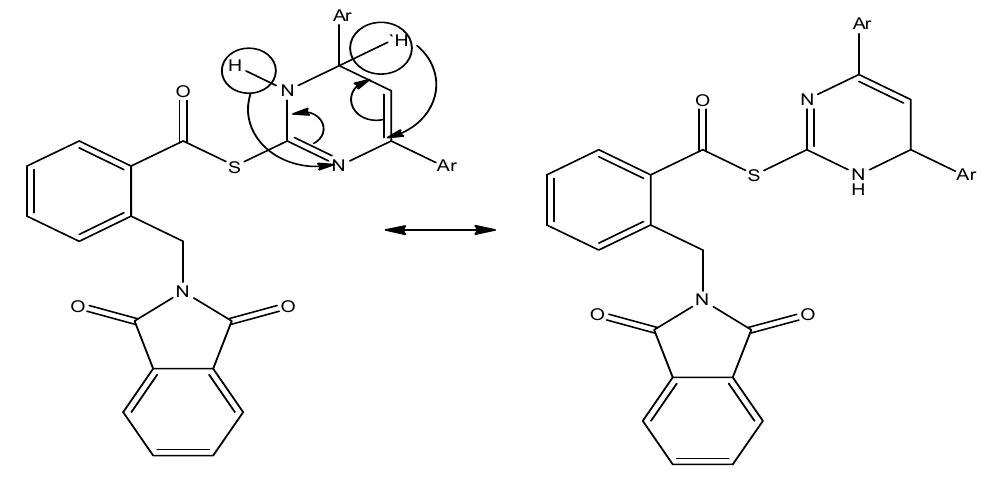
Figure 7. Equivalence of positions 2 and 4 in